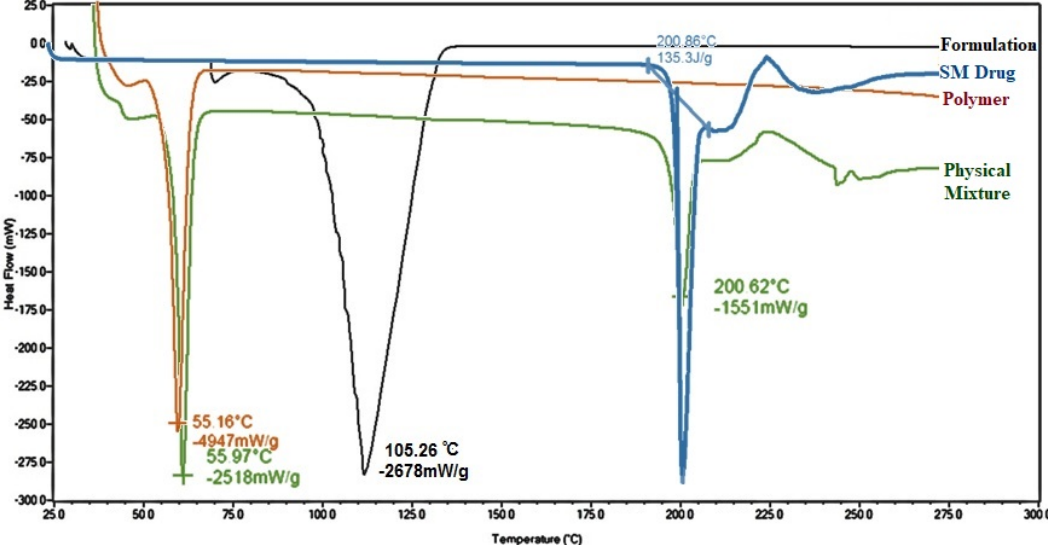
Figure 2. The differential scanning calorimetry (DSC) spectra of the formulation (SM-MPEG-PCL micelles), the SM drug (sunitinib malate pure drug), the polymer (MPEG-PCL polymer alone), and the physical mixture (the physical mixture of SM and MPEG-PCL).